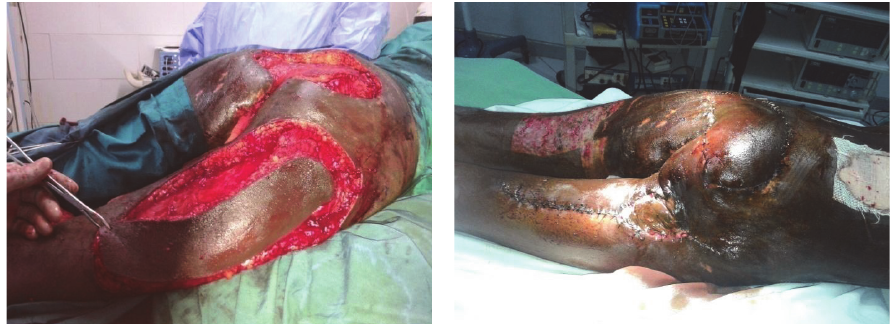
Figure 2: Island posterior thigh flap being raised in the first patient with no recurrence at three months of follow-up.